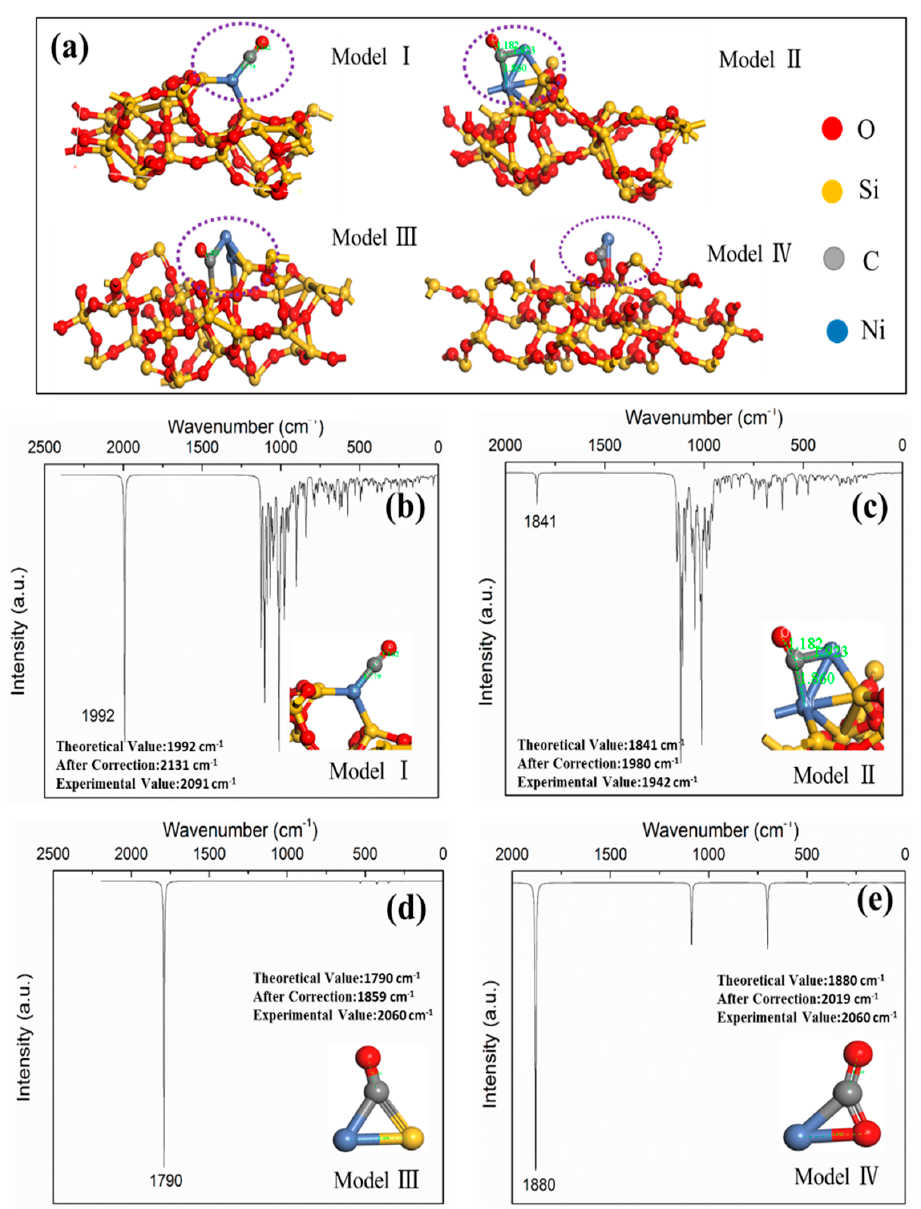
Figure 3. ( a ) CO adsorption model at different sites. DFT results of ( b ) SiO 2 (111)-modified-CO–Ni- top-spectrum, ( c ) SiO 2 (111)-modified-Ni-bridge-spectrum, ( d ) Si–Ni-spectrum and ( e )